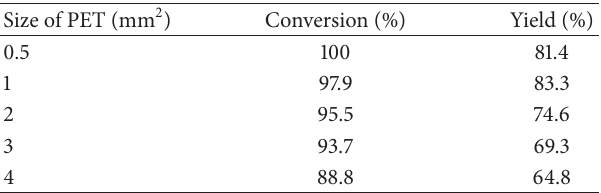
Table 3: The effects of size on the glycolysis of PET a . Size of PET (mm 2